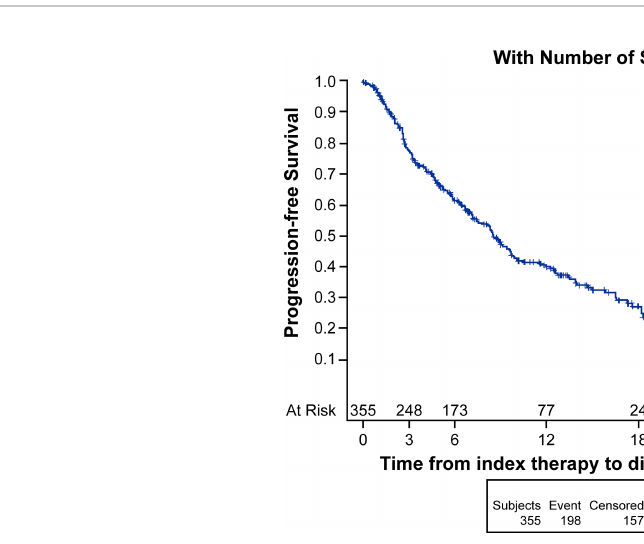
( Figure 2 ). Table 3 describes TTF, rwPFS, and OS during follow- up at speci fi ed landmark timepoints (3, 6, 9, and 12 months).